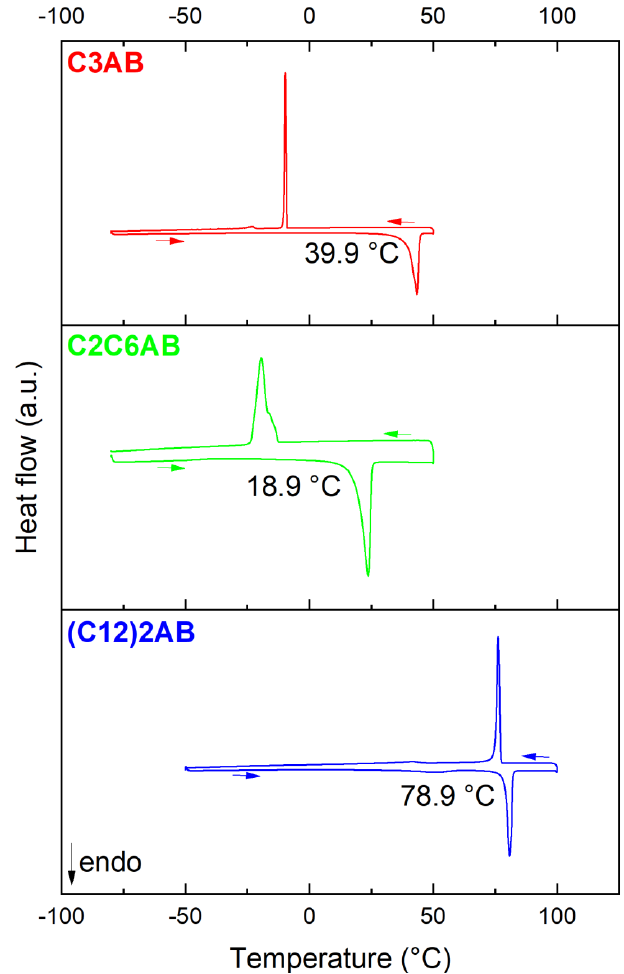
Figure 3. DSC curves of C3AB, C2C6AB and (C12)2AB with the onset temperature of the melting event mentioned.